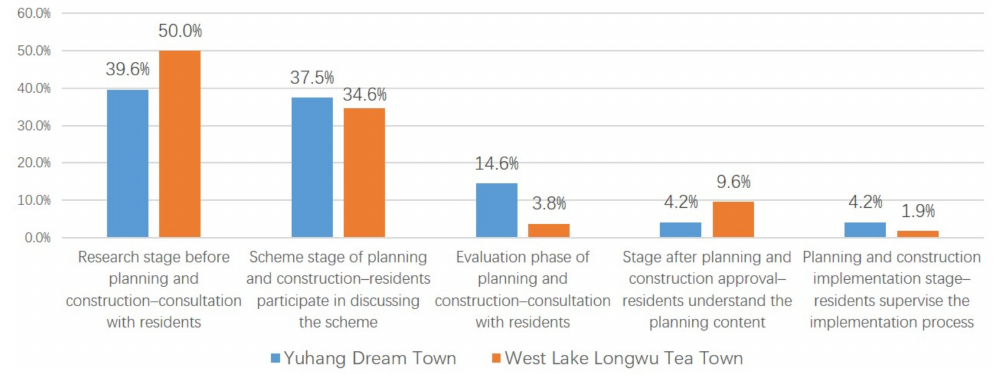
Figure 21. Respondents’ judgments about the stage in which residents should be involved (source: authors).